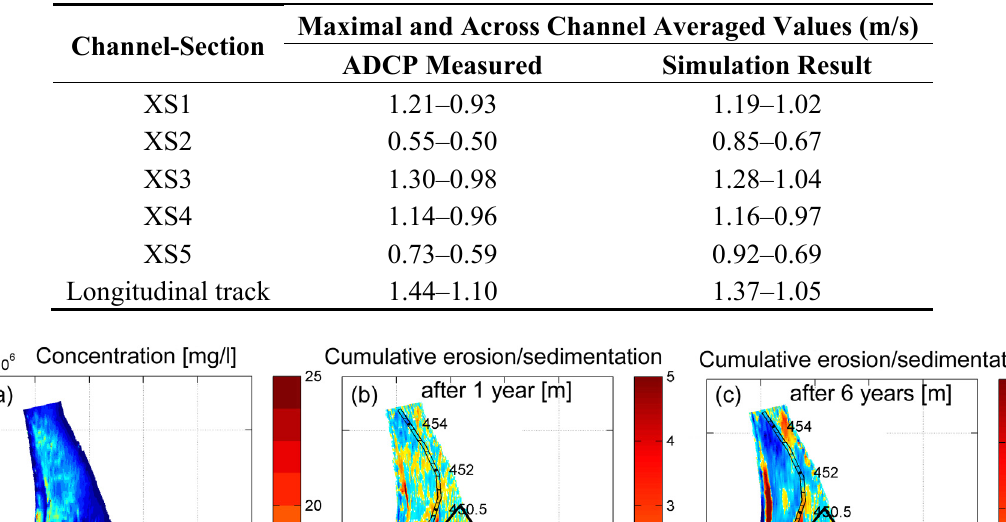
Table 2. Comparison between measured and simulated (2009 campaign with an average discharge of 13,600 m 3 /s) depth-averaged magnitude of flow velocities.